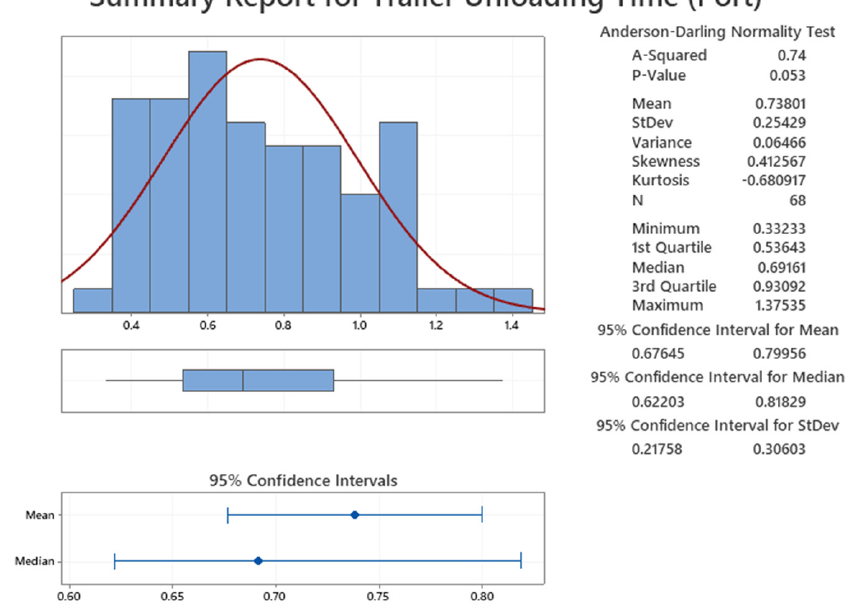
Figure 8. Trailer unloading performance at the port.